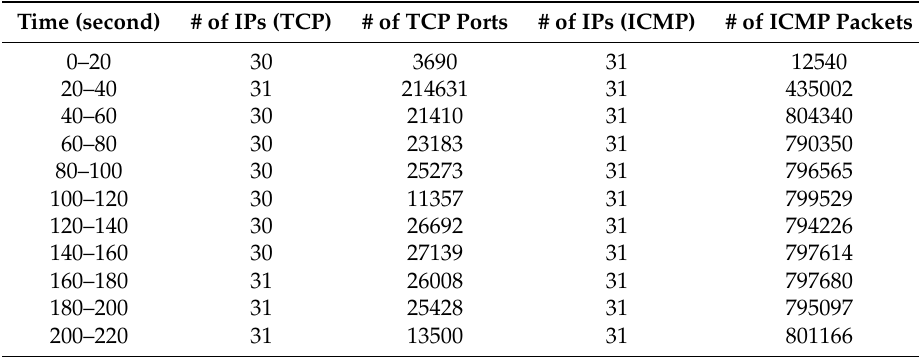
Table 2. Number of active IPs and ports in dataset generated by